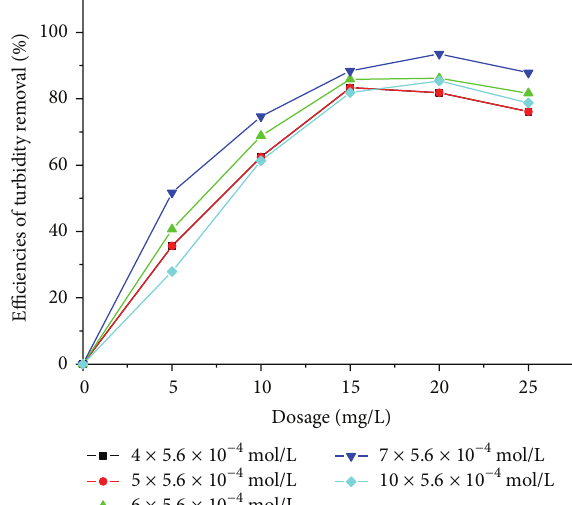
Figure 6: Effects of concentration of initiators on turbidity removal for